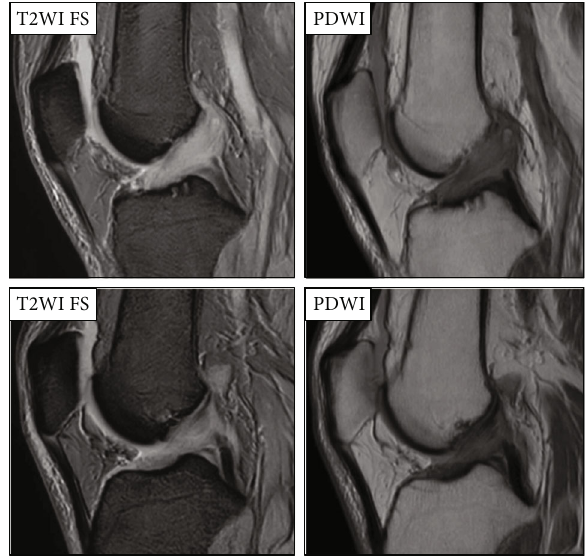
Figure 3: MRI showed di ff use thickening of both ACLs, which are called celery stalk sign, with high inhomogeneous intensity in the T2-weighted and proton density weighted